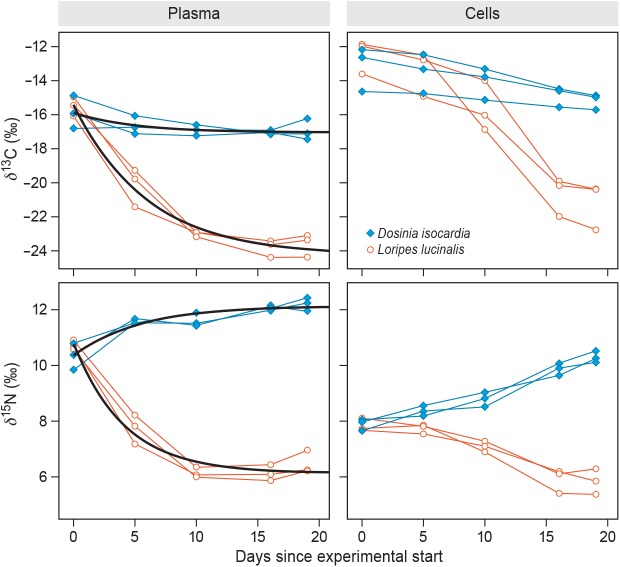
Isotope ratios δ
13C (upper panels) and δ
15N (lower panels) throughout the experiment in blood plasma (left panels) and red blood cells (right panels).Individual measurements are connected, diets are given in legend (upper right panel), and thicker lines denote nonlinear mixed-effect model fits (plasma only; model fits failed to converge for red blood cells).